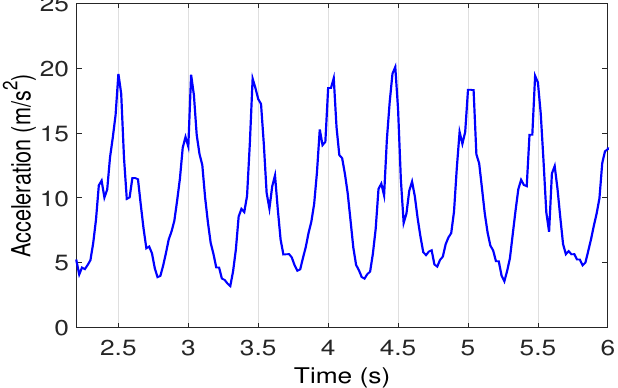
Figure 2. Recordings from accelerometers while pedestrians are